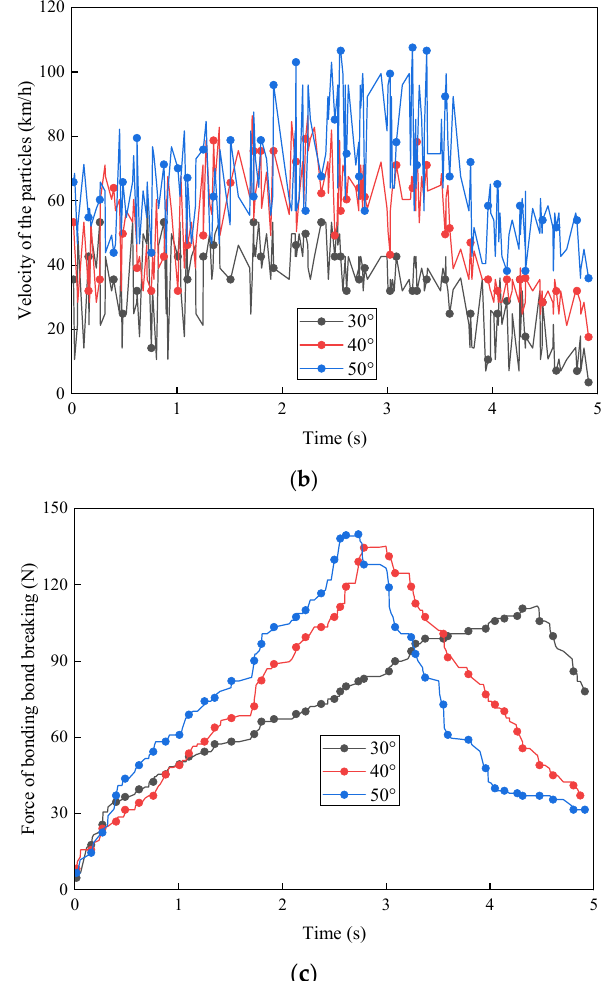
Figure 8. Influence of different guide plate angle on the particles. ( a ) Force curves of particles. ( b ) Velocity curves of particles. ( c ) Breaking force curves of the seed-stalk bonding bond.